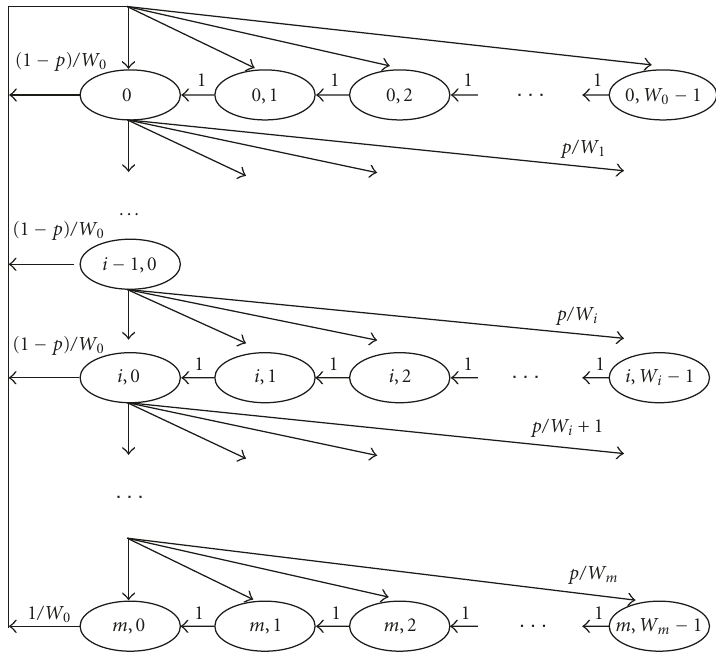
Figure 3: Two-dimensional Markov chain backo ff model in consideration of packet collision and channel